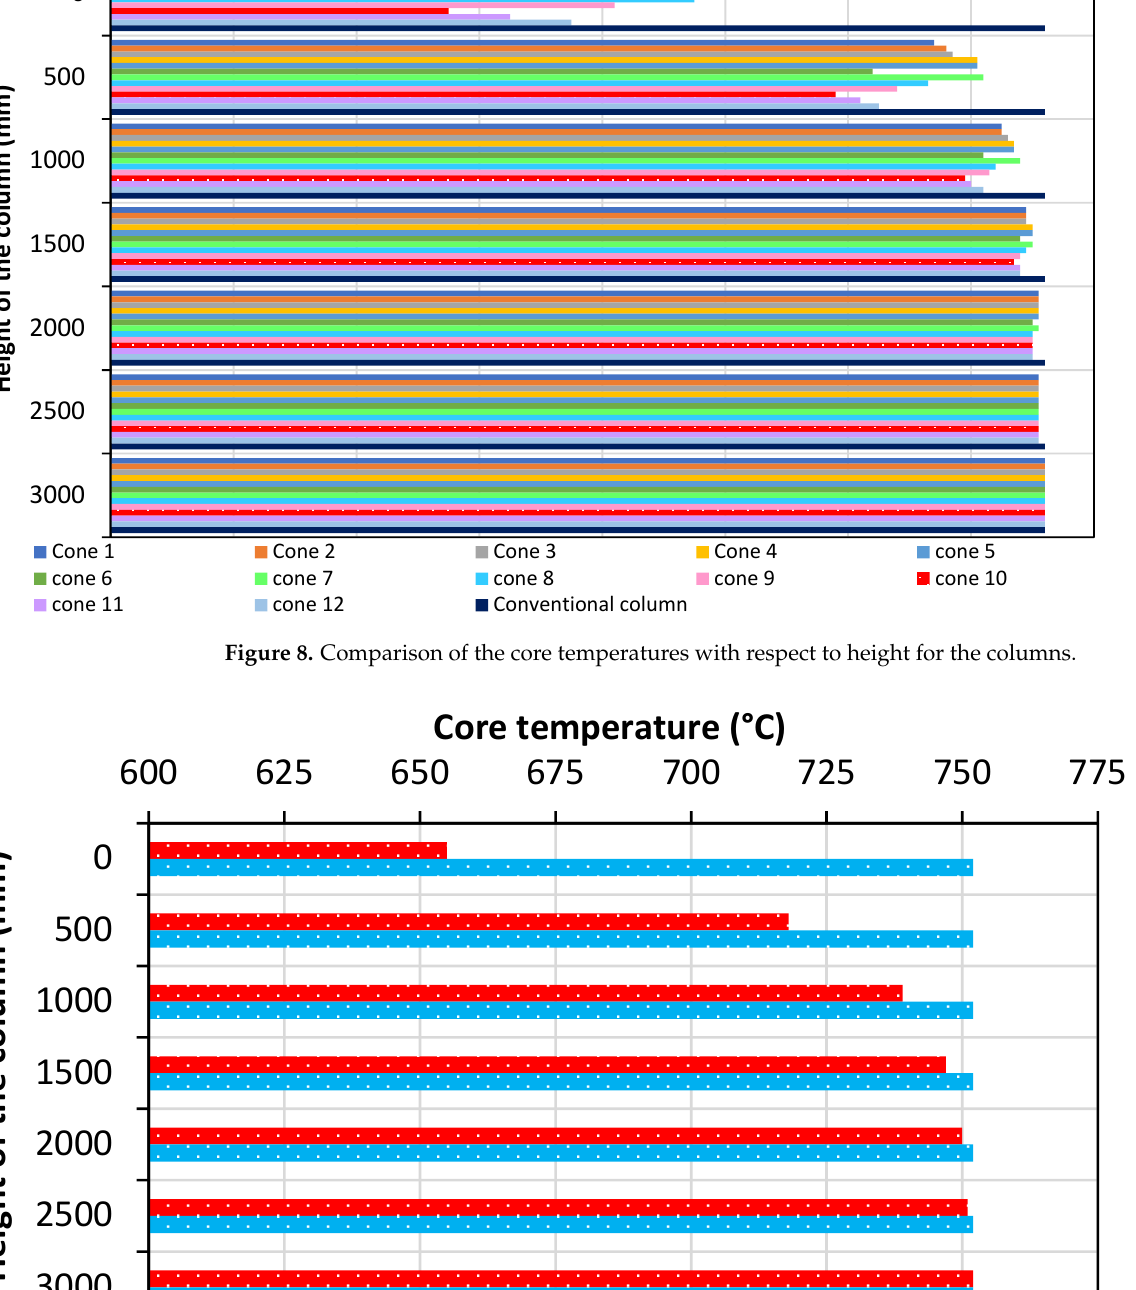
( a ) ( b ) Figure 10. ( a ) Heat release contours of the conventional column and ( b ) heat release contours of the mimicked column with cone 10. 4. Experimental Setup A scaled-down model of a reinforced concrete column was considered to validate the effect of heat dissipation in the mimicked column through experiments. For experimental purposes, the columns were scaled down to a ratio of 1:4 from the prototype model. The scaled-down model has a cross-section of 75 x 100 mm and a height of 750 mm. It com- prises 4 numbers of 6 mm diameter bars as the main reinforcement and 6 mm lateral ties as a spacing of 50 mm C/C. For the mimicked shape, the mold was prepared using mild steel. A wooden mold was prepared for the columns. The mimicked part was attached to the wooden mold at the top through bolts. The dimensions of the scaled-down mimicked shape are given in Figure 11.